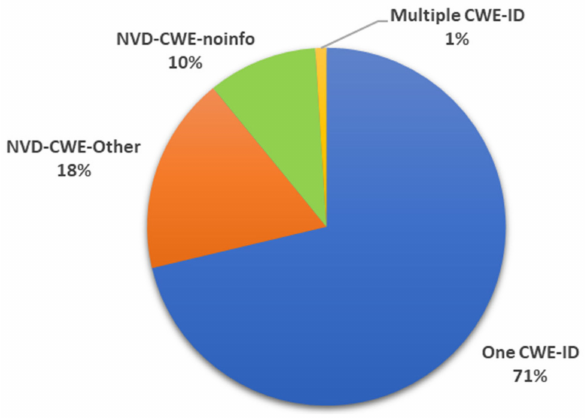
Figure 6. Percentage of CVE-IDs not linked to